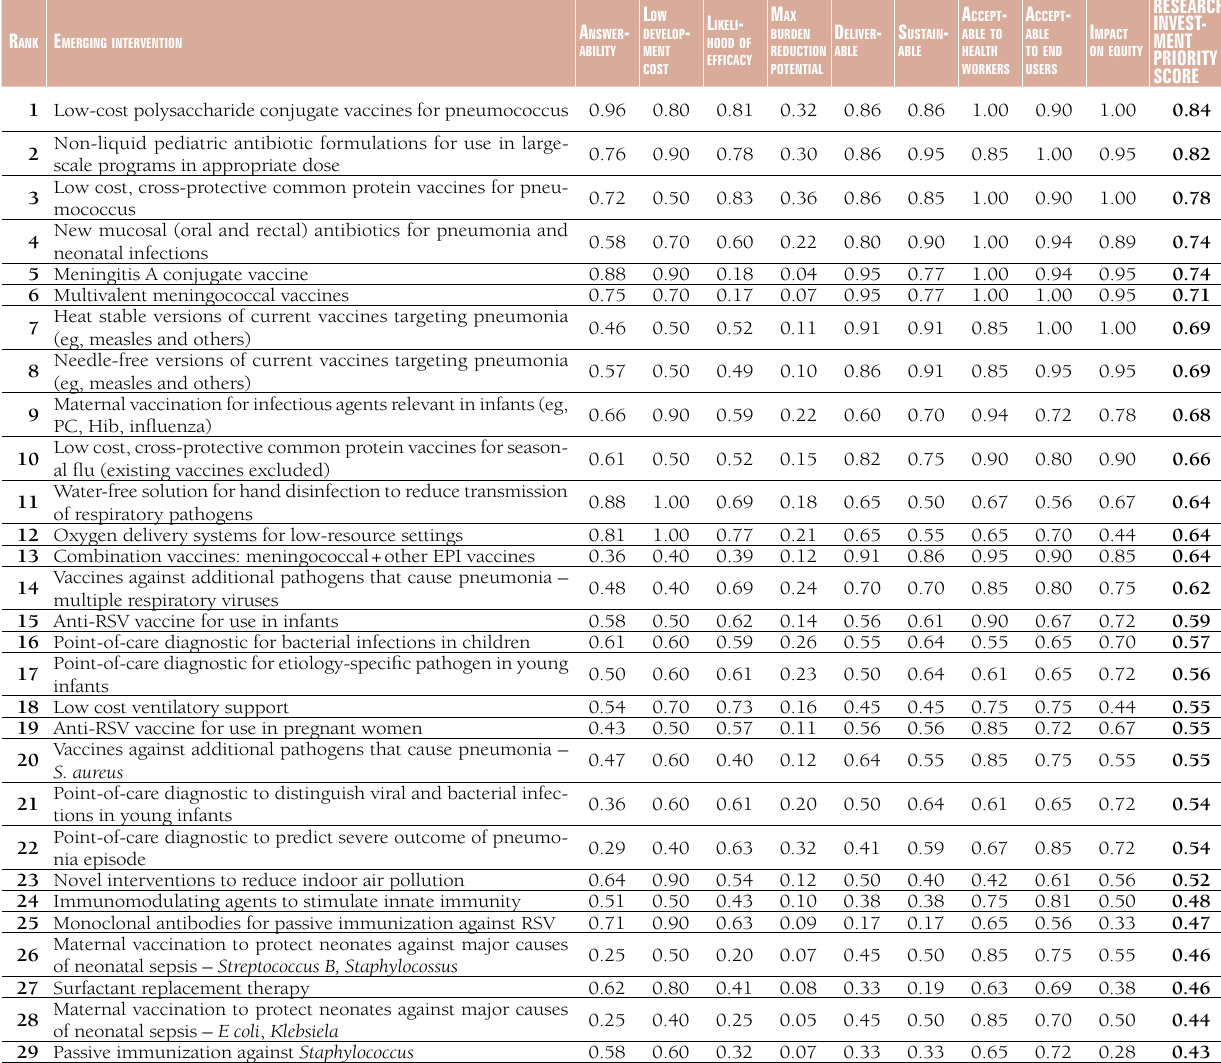
Table 3 The results of the CHNRI exercise: 29 emerging interventions with 9 intermediate scores and an overall research priority score r ank e merging